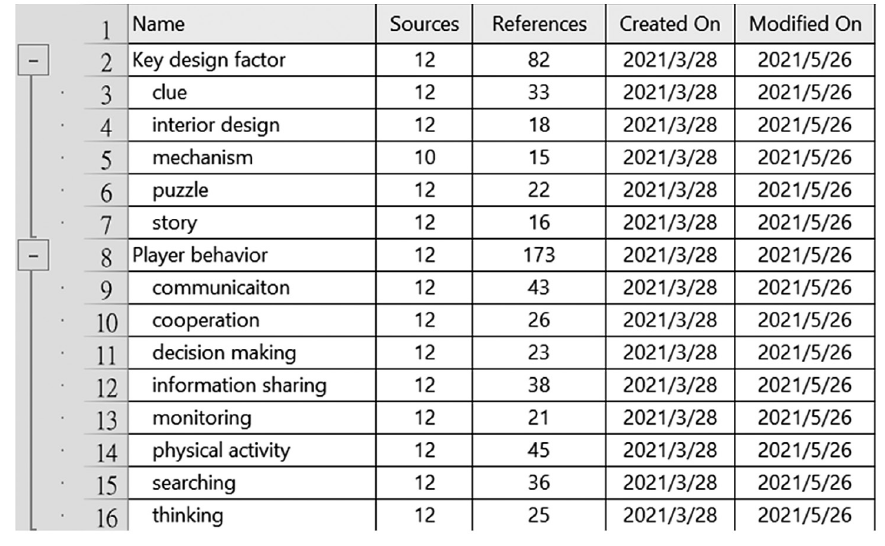
Figure 4. Example of users’ needs code list generated from the